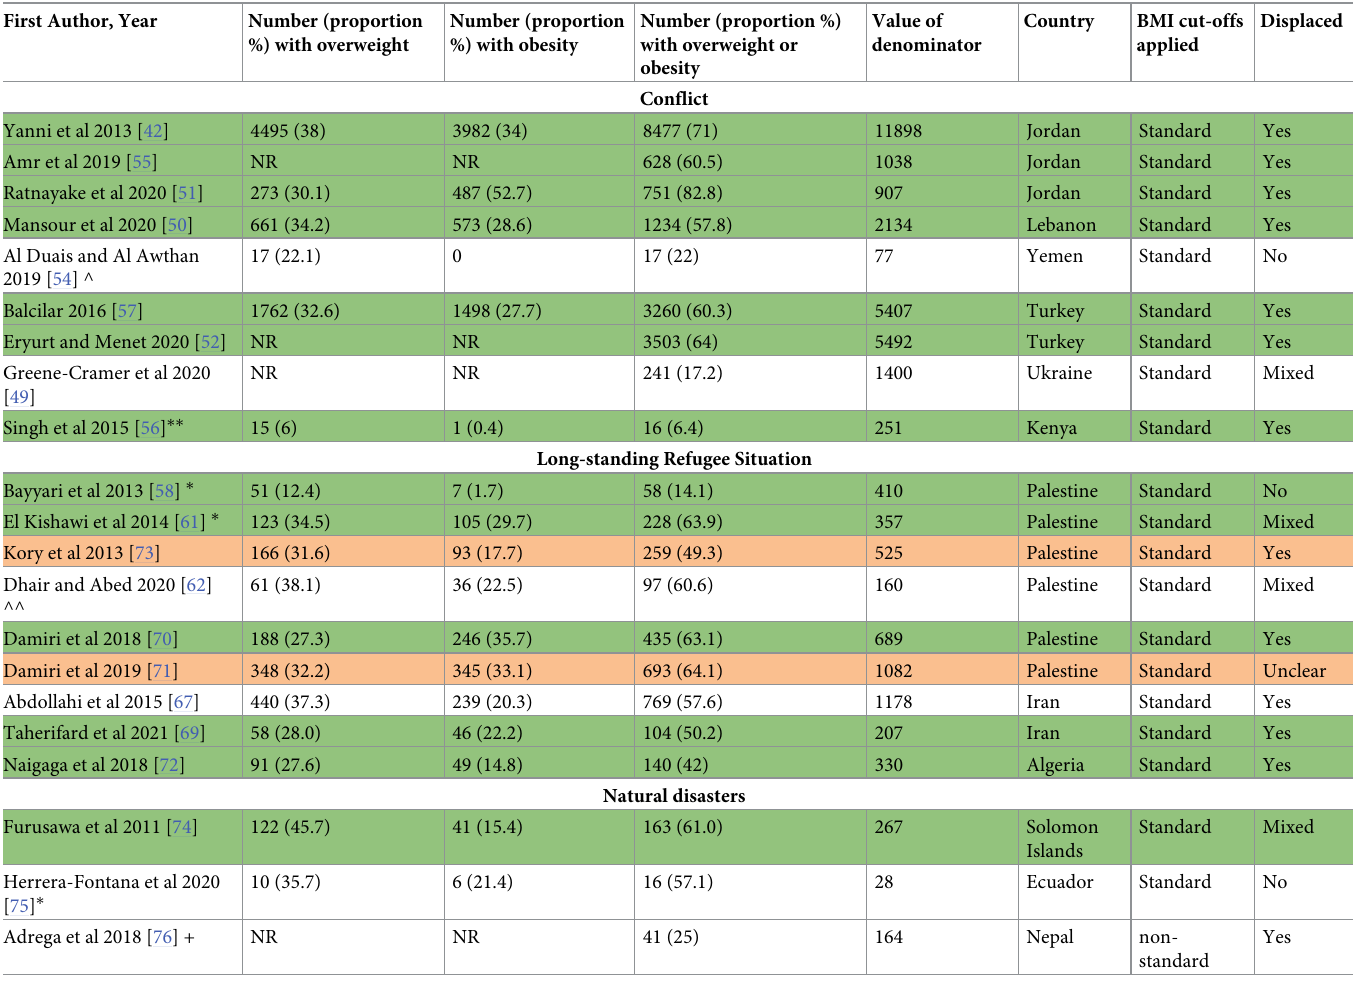
Table 2. Showing prevalence of overweight and obesity in studies carried out in low and middle income